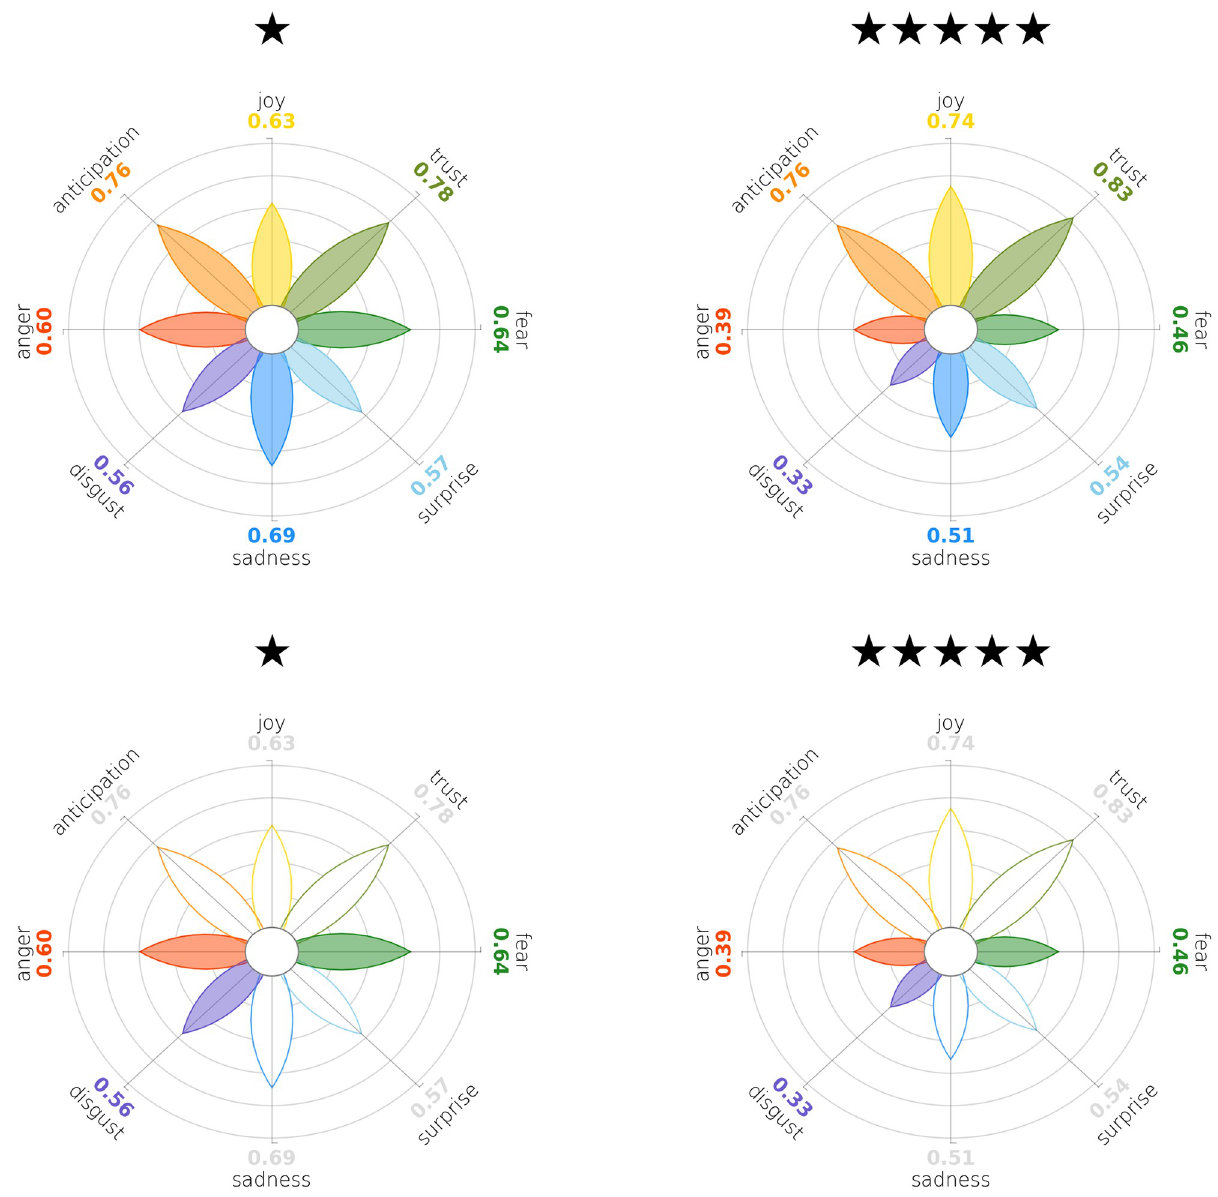
Fig 11. Focus-plus-context: The selective presentation feature of PyPlutchik allows to put emphasis on some particular emotions, without losing sight of the others; we can compare different subgroups of the same Amazon corpus placing our visualisations side-by-side, and highlighting only Anger , Disgust and Fear petals, to easily spot how these negative emotions are under represented in 5-stars reviews than in 1-star reviews.